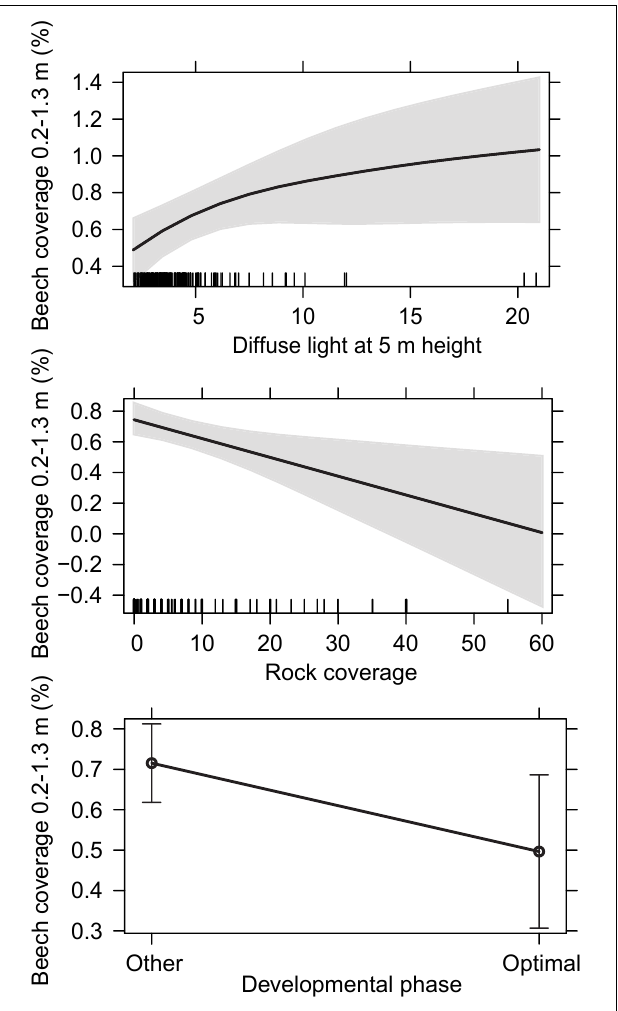
FIGURE 5 | Effect display for significant factors in the regression model for the coverage of beech between 0.2 and 1.3 m height. The gray areas represent 95-percent confidence envelopes around the fitted